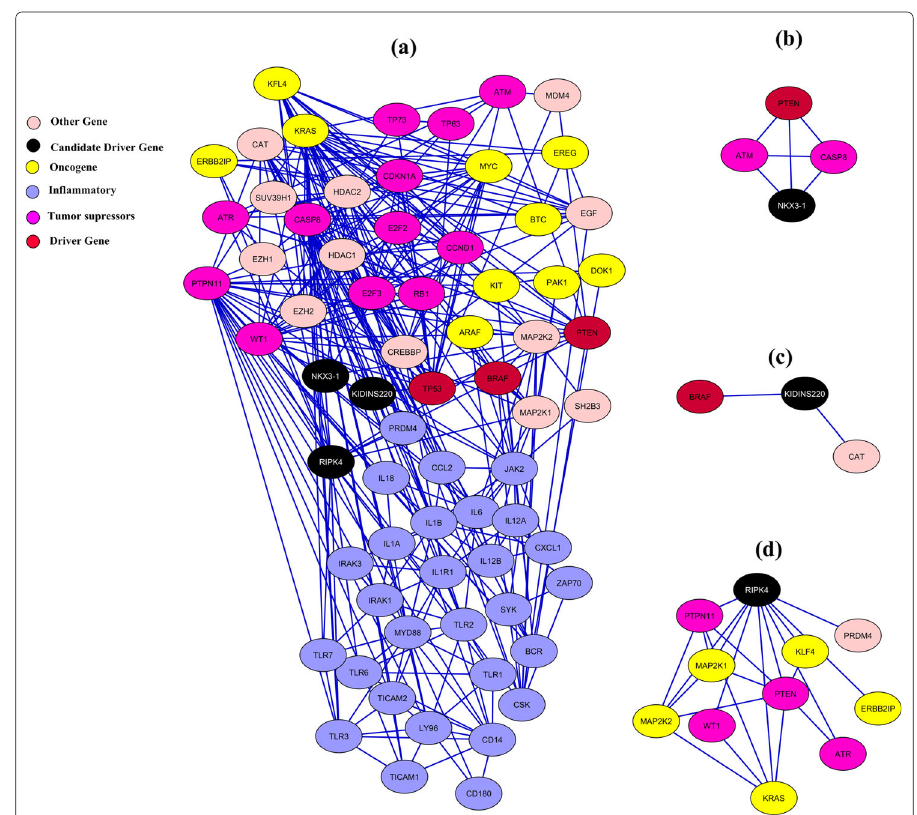
Fig. 2 Gastrointestinal network. The figures depict graph C d using 0.95 threshold in STRING